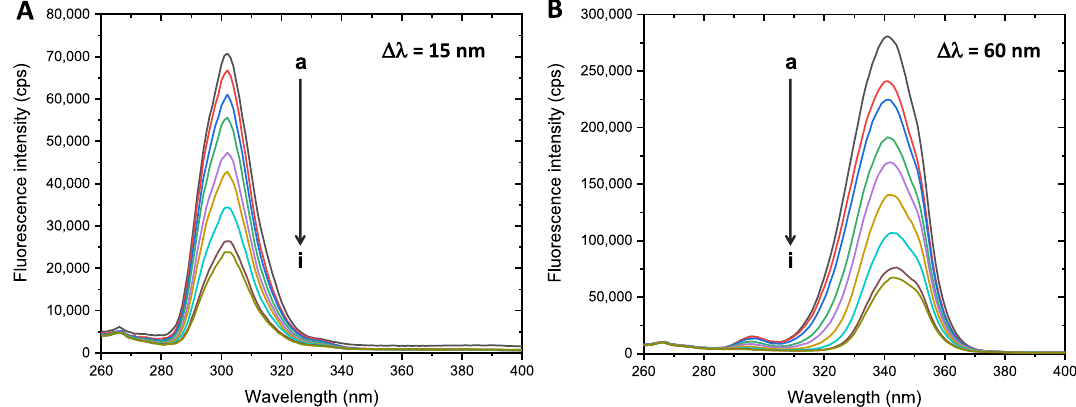
Figure 5. Synchronous fluorescence spectra of BSA (4 µM) when exposed to 5A8HQ (a–i: 0, 5, 10, 30, 50, 70, 110, 150, and 170 µM) at 310 K and 280 nm excitation wavelength. ( A ) Tyrosine spectra (Δλ = 15 nm) and ( B ) tryptophan spectra (Δλ = 60